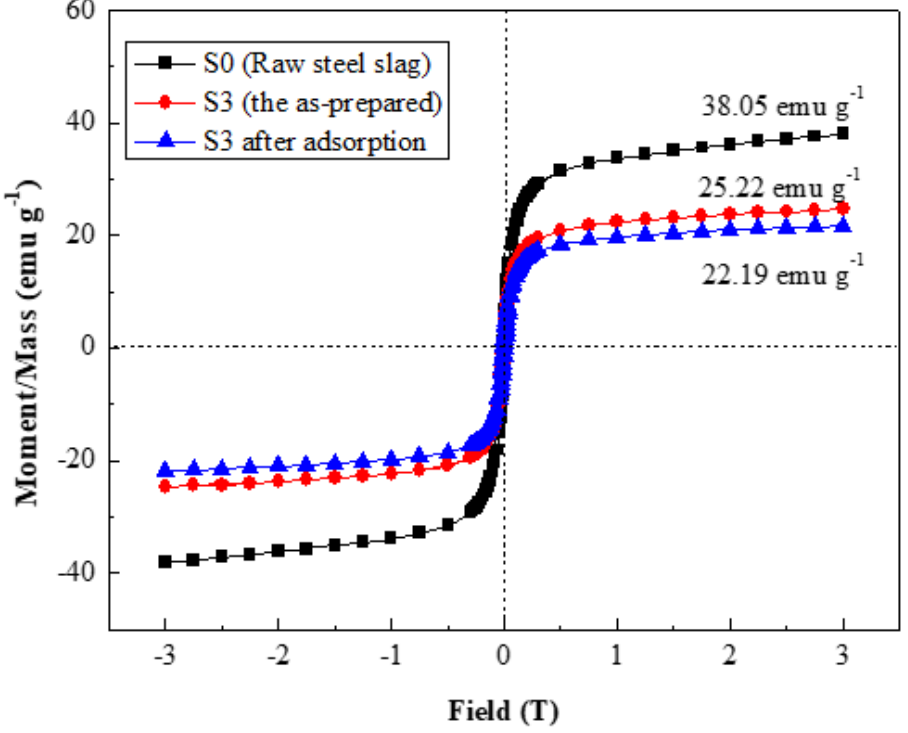
Figure 7. VSM curves for raw steel slag, the as-prepared S3, and S3 after adsorption of Pb 2+ .